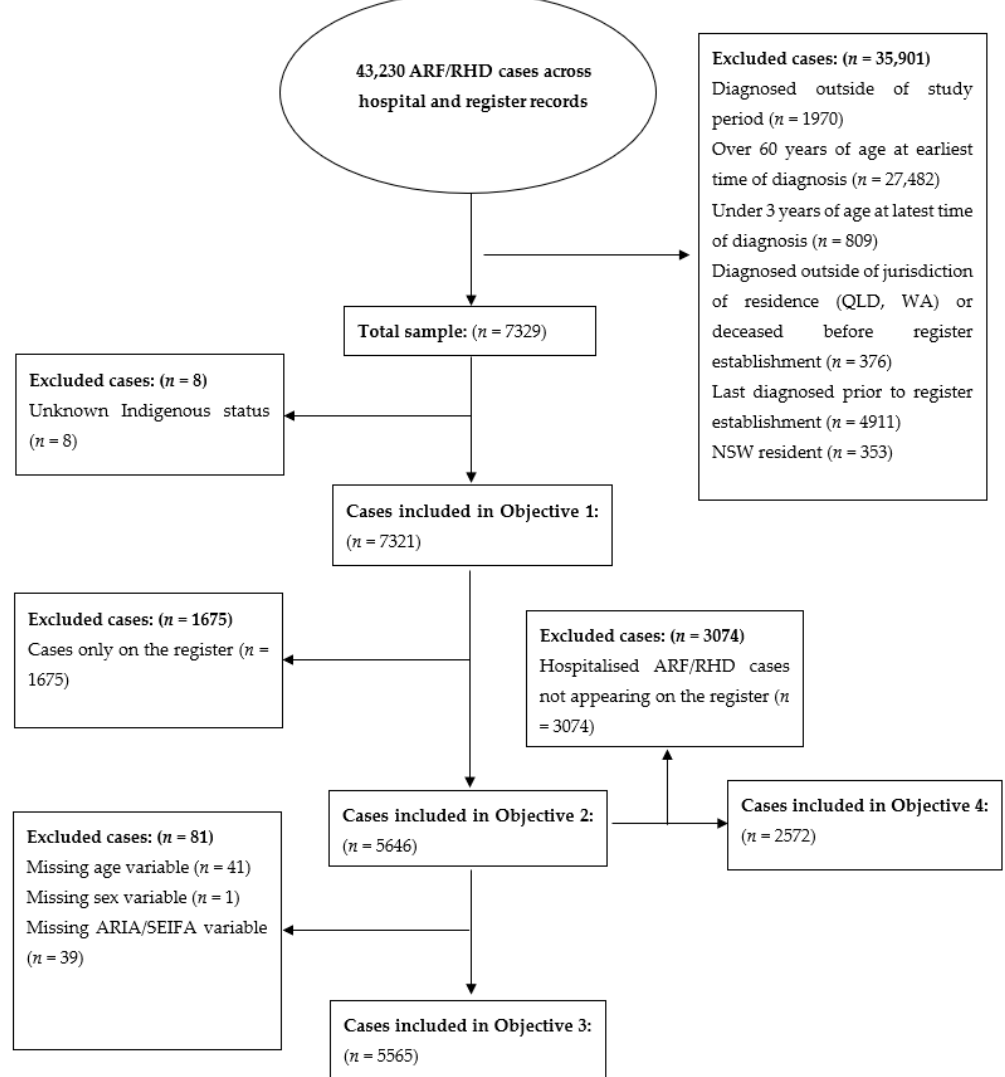
Figure 2. Flowchart of sample selection.